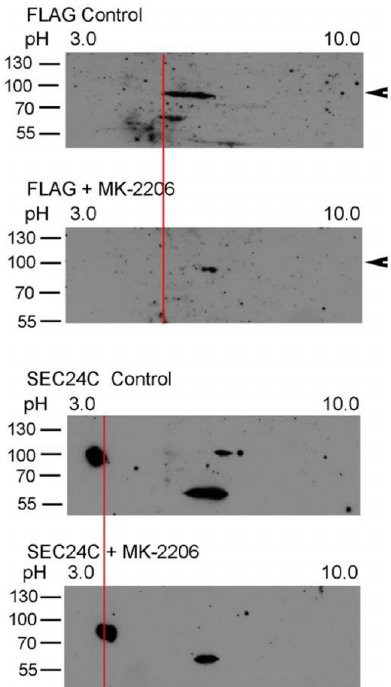
Figure 3. Two-dimensional analysis of SLC6A14 and SEC24C phosphorylation. HEK293 cells transfected for 24 h with p3xFLAG-CMV14/B 0,+ were treated, where indicated, for 30 min with 5 µM MK-2206. The cells were lysed, as described in Section 2.2, and the lysates were analyzed via 2D electrophoresis. The change in pI is marked by a red line. The arrows show the migration of a fully glycosylated SLC6A14. Representative blots out of 4 independent experiments are shown.